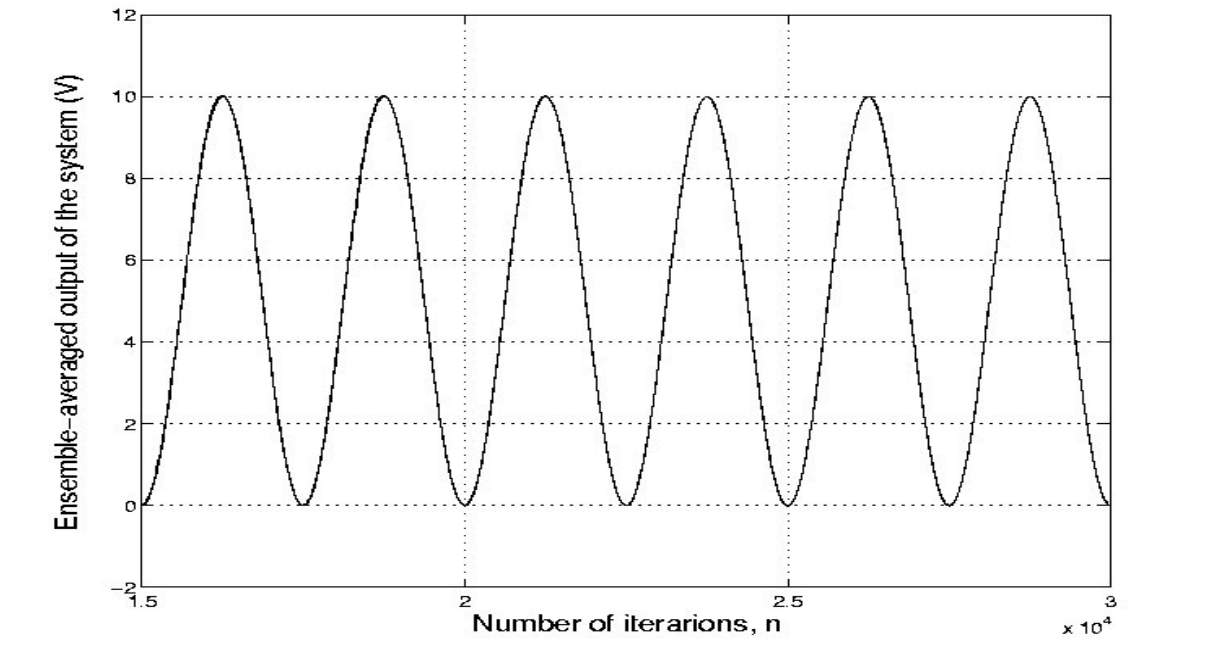
Figure 6. The ensemble-averaged output of the system over 200 independent trials of the experiment from n = 15000 to n = 30000 with R = 9 and λ = 1 (1V = 4.5 0